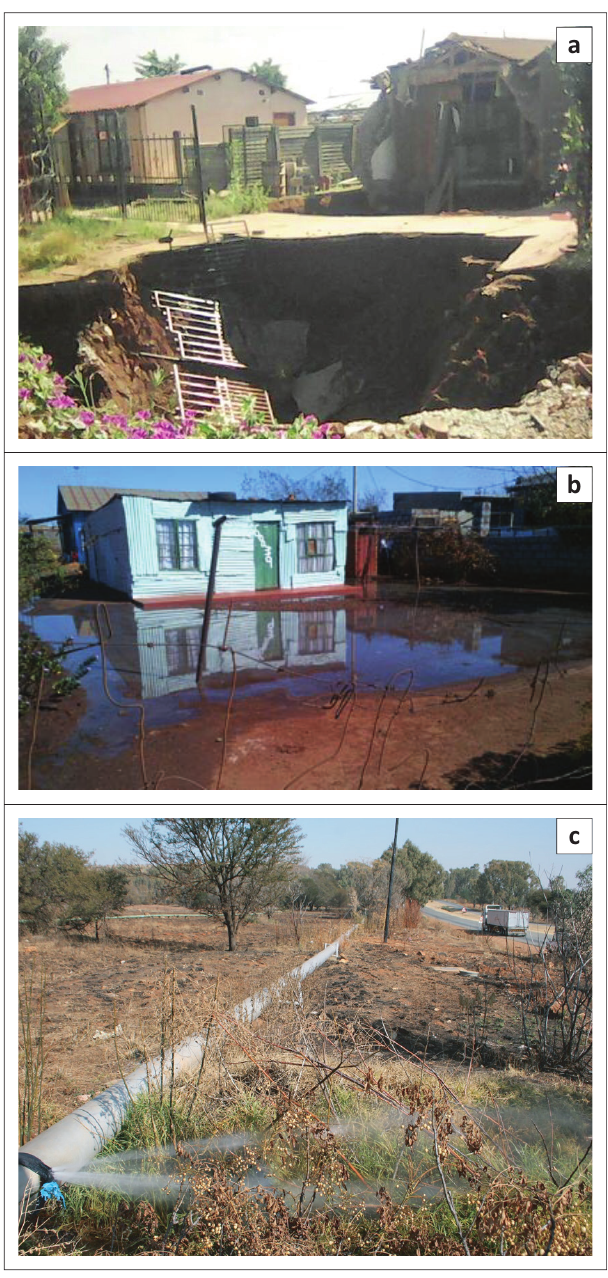
FIGURE 3: Photos depicting the state of destruction in and around the Khutsong area.